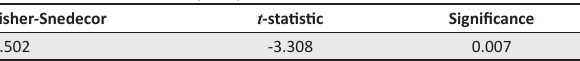
TABLE 6: Levene’s test of equality.